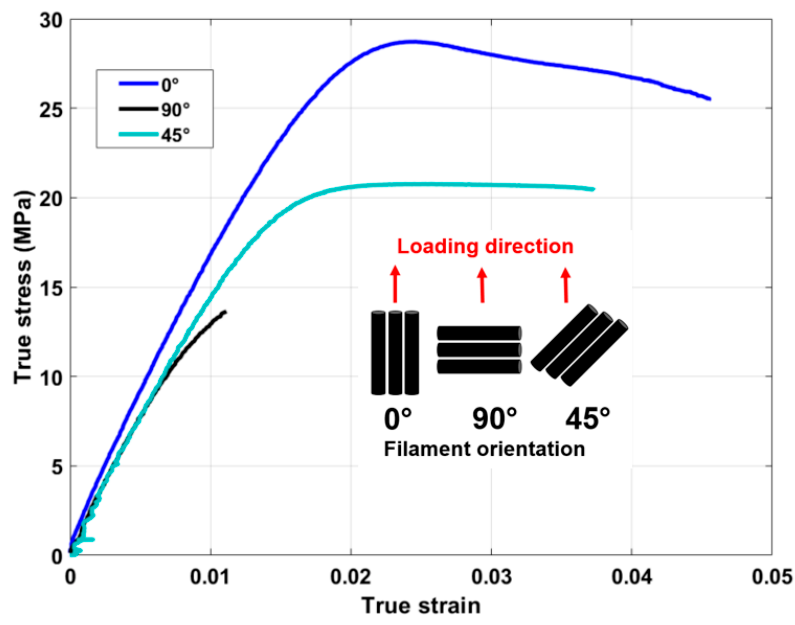
Figure 5. Tensile curves of three samples with different filament orientations (0 ◦ , 45 ◦ , and 90 ◦ Figure 5 . Tensile curves of three samples with different filament orientations (0°, 45°, and 90°).